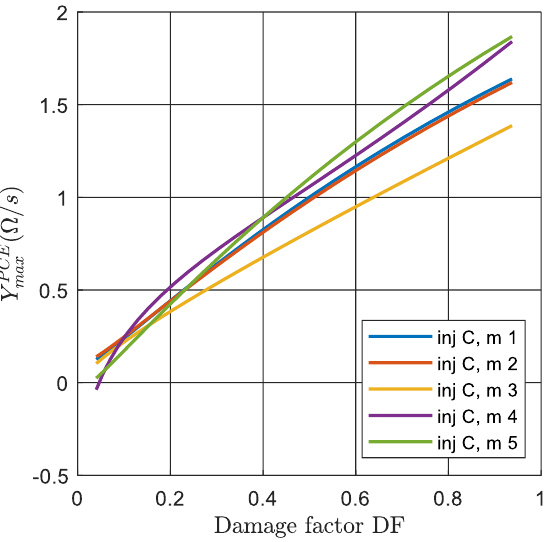
Fig.13: Changing of 𝑌̂ 𝑚𝑎𝑥𝑃𝐶𝐸 by the damage factor for injection from source electrodes C (inj C) and measurement from five electrode pairs (m1 to m5).